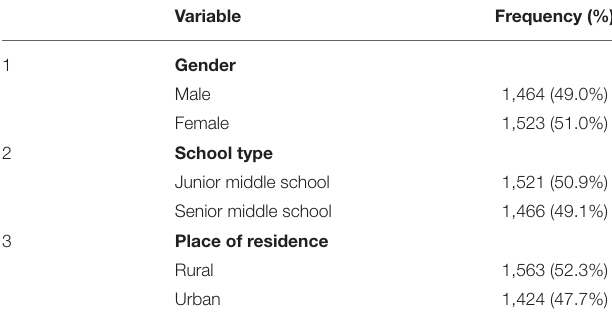
TABLE 1 | Sample characteristics ( N =